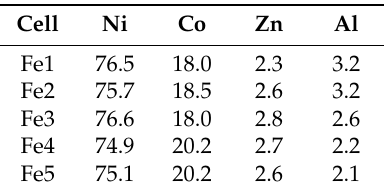
Table 4. Chemical compositions (at%) measured by EDS of the positive electrodes after cycle life testing at